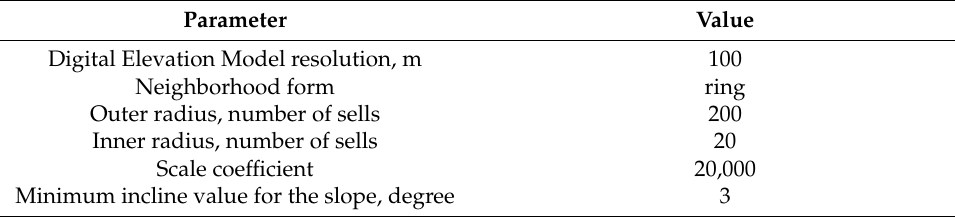
Table 1. Parameters, used for the calculation of the Broad Scale Bathymetric Position Index (B-BPI).